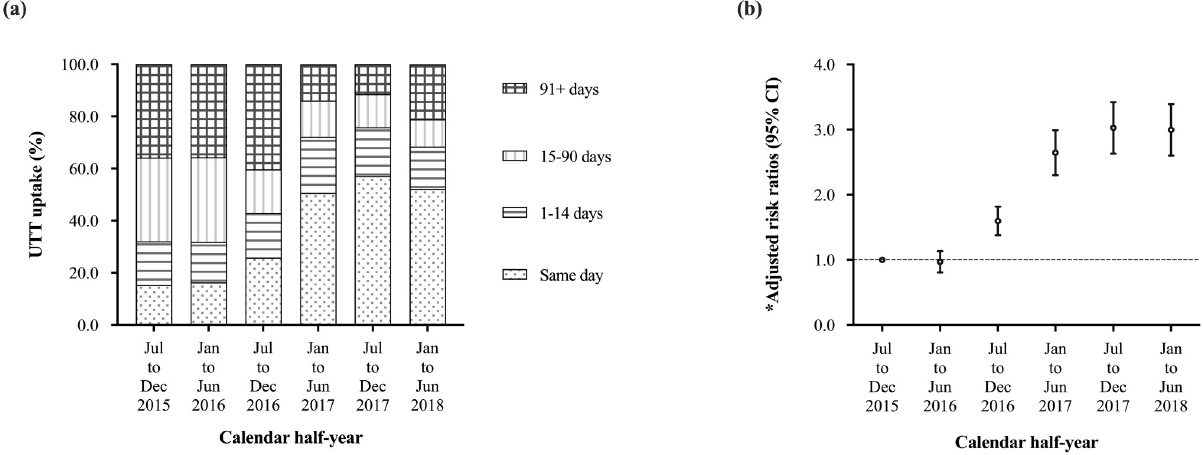
Fig 2. Uptake of universal test-and-treat presented as proportions of HIV infected individuals starting combination antiretroviral therapy on the same day, 1–14 days, 15–90 days and 91+ days from a HIV diagnosis using data from the national data warehouse in Kenya (2015HY2 to 2018HY1, N =